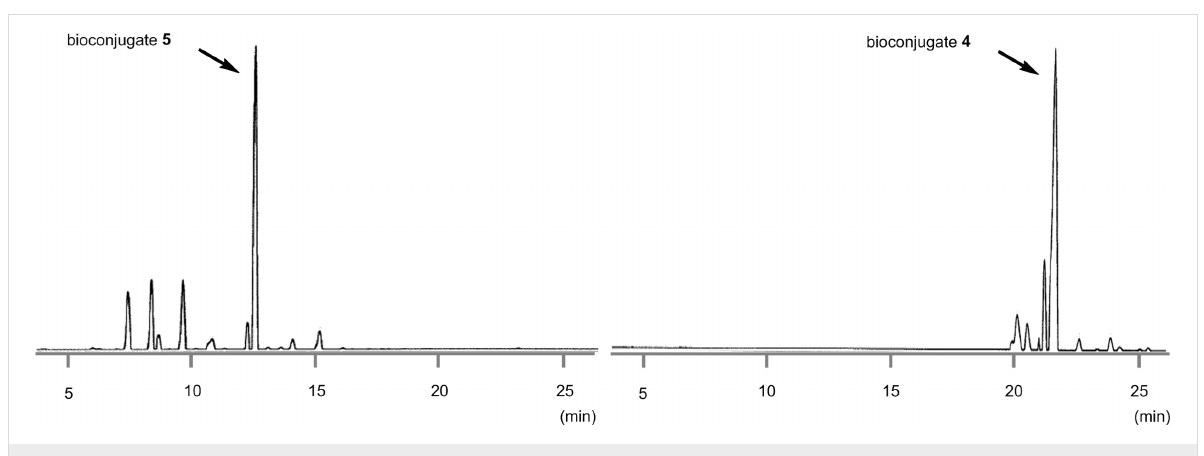
Figure 3: HPLC spectra of the crude protected bioconjugate 4 and the crude deprotected bioconjugate 5